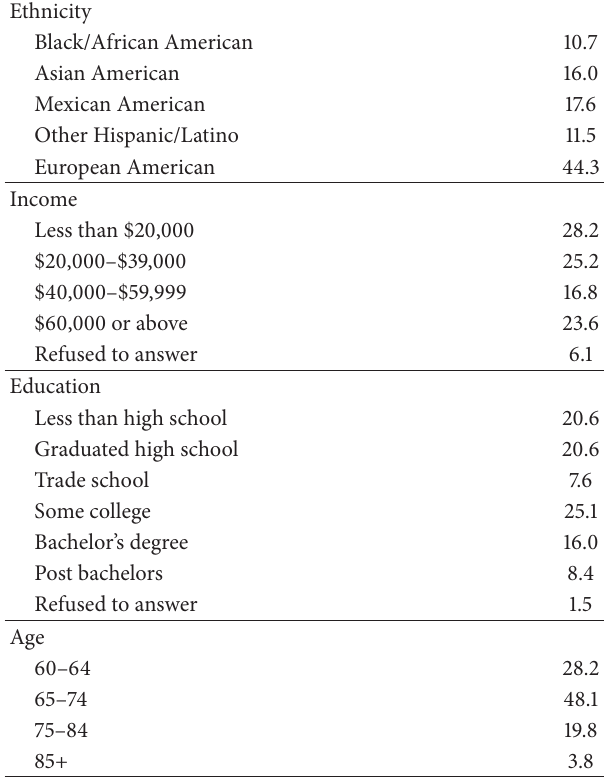
Table 1: Demographic characteristics of the sample (𝑛 = 131)